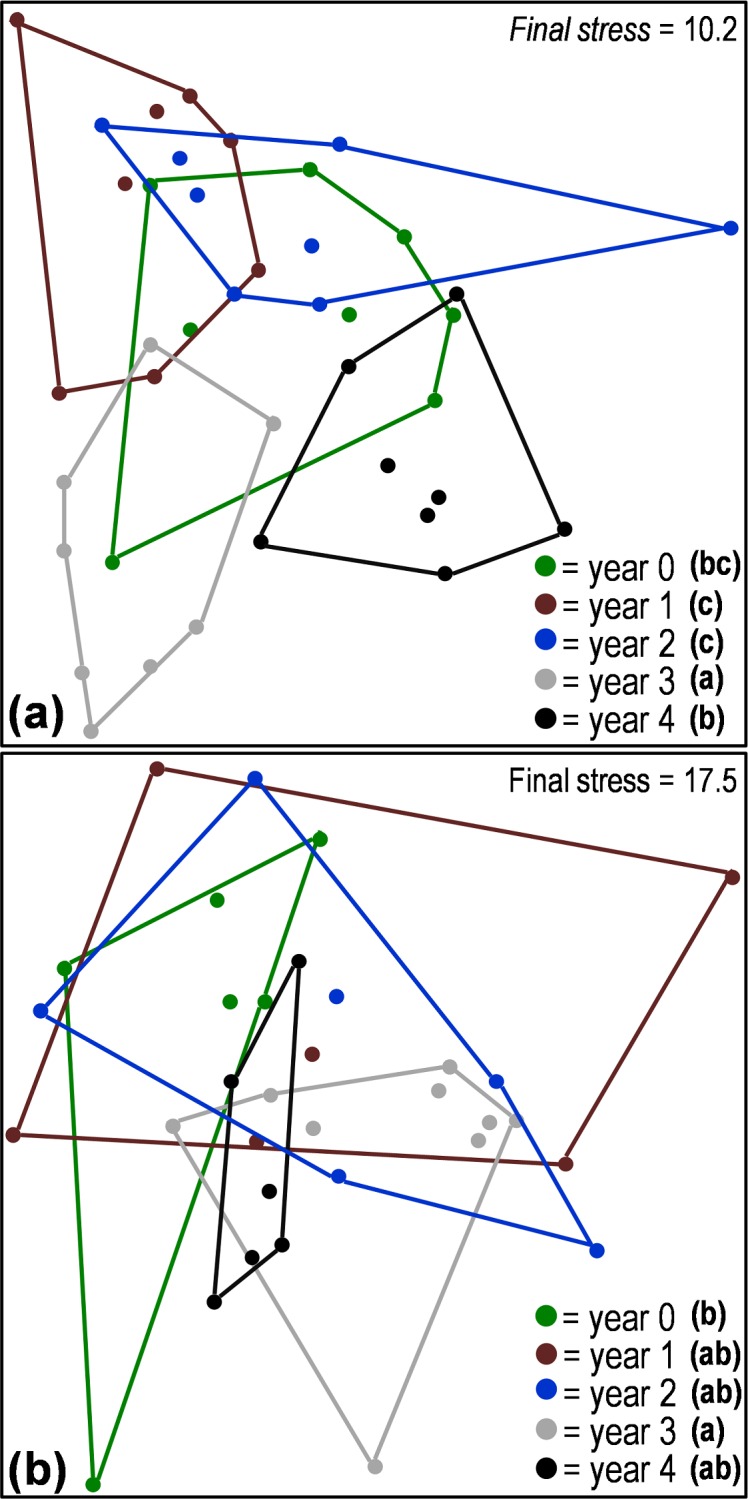
Non-metric multi-dimensional scaling (NMDS) ordination based on Bray–Curtis distances comparing the structure of aboveground (A) and belowground (B) arthropod communities from samples collected along a five-year chronosequence of insect-induced tree mortality.Chronosequence years with different letters in the legend indicate communities that are significantly different (PERMANOVA P < 0.05).